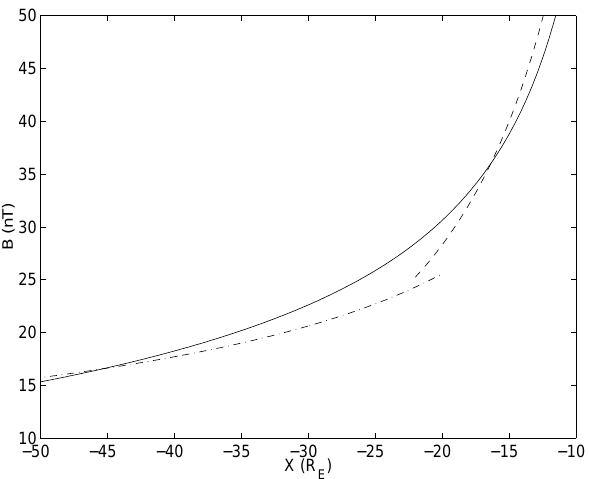
Fig. 4. Model lobe field (solid) calculated at (Y,Z) = ( 0 , 10 )R E is compared to the observations of Slavin et al. (1985) (dot-dash) and Nakai et al. (1991) (dashed).